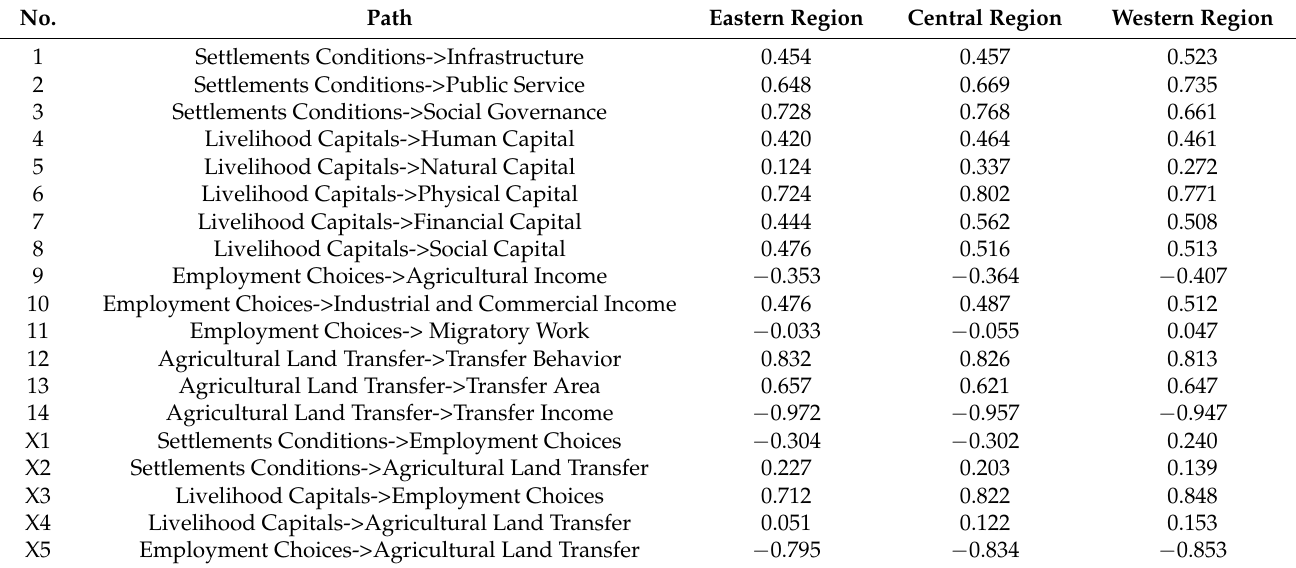
Table 6. The structural model path coefficients for different